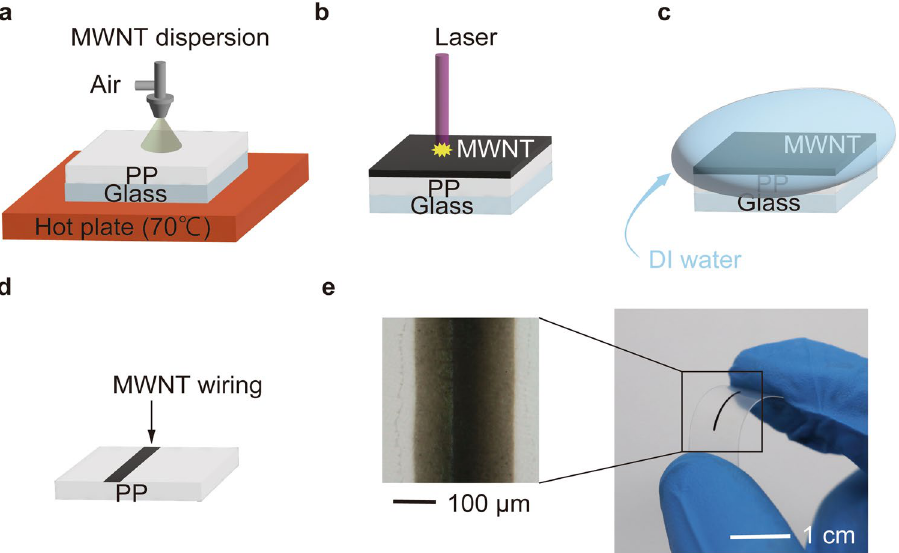
Figure 1. Schematic illustration of fabrication of CNT wiring on polypropylene substrate. ( a ) Schematic of CNT film formation on PP. ( b ) Laser irradiation of CNT film on PP. ( c ) Schematic of cleaning with DI water after laser irradiation and ( d ) after cleaning. ( e ) Fabricated CNT wiring on PP under